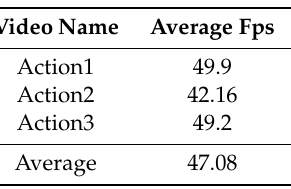
Table 1. Computation time performance in frames per second (fps).